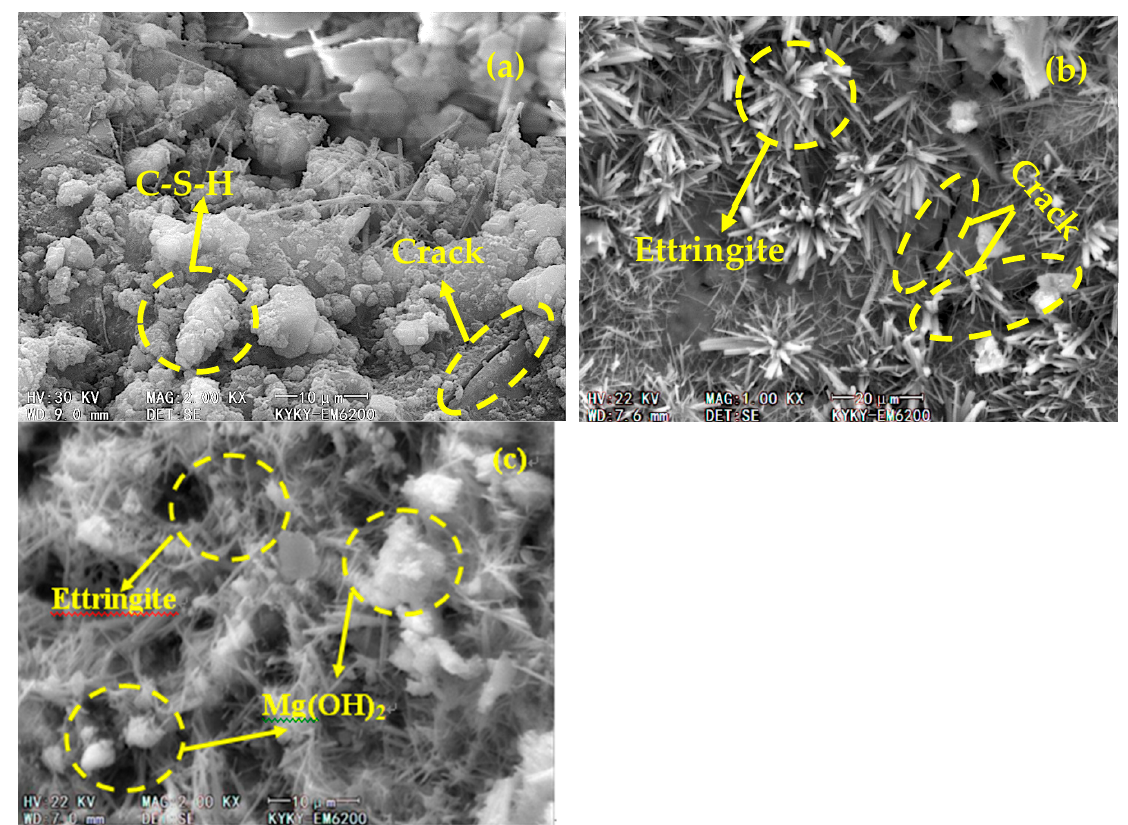
Figure 7. Microstructures of various concretes after 125 freezing and thawing cycles: ( a ) PC; ( b ) UM 10 ; and ( c ) UM 21.